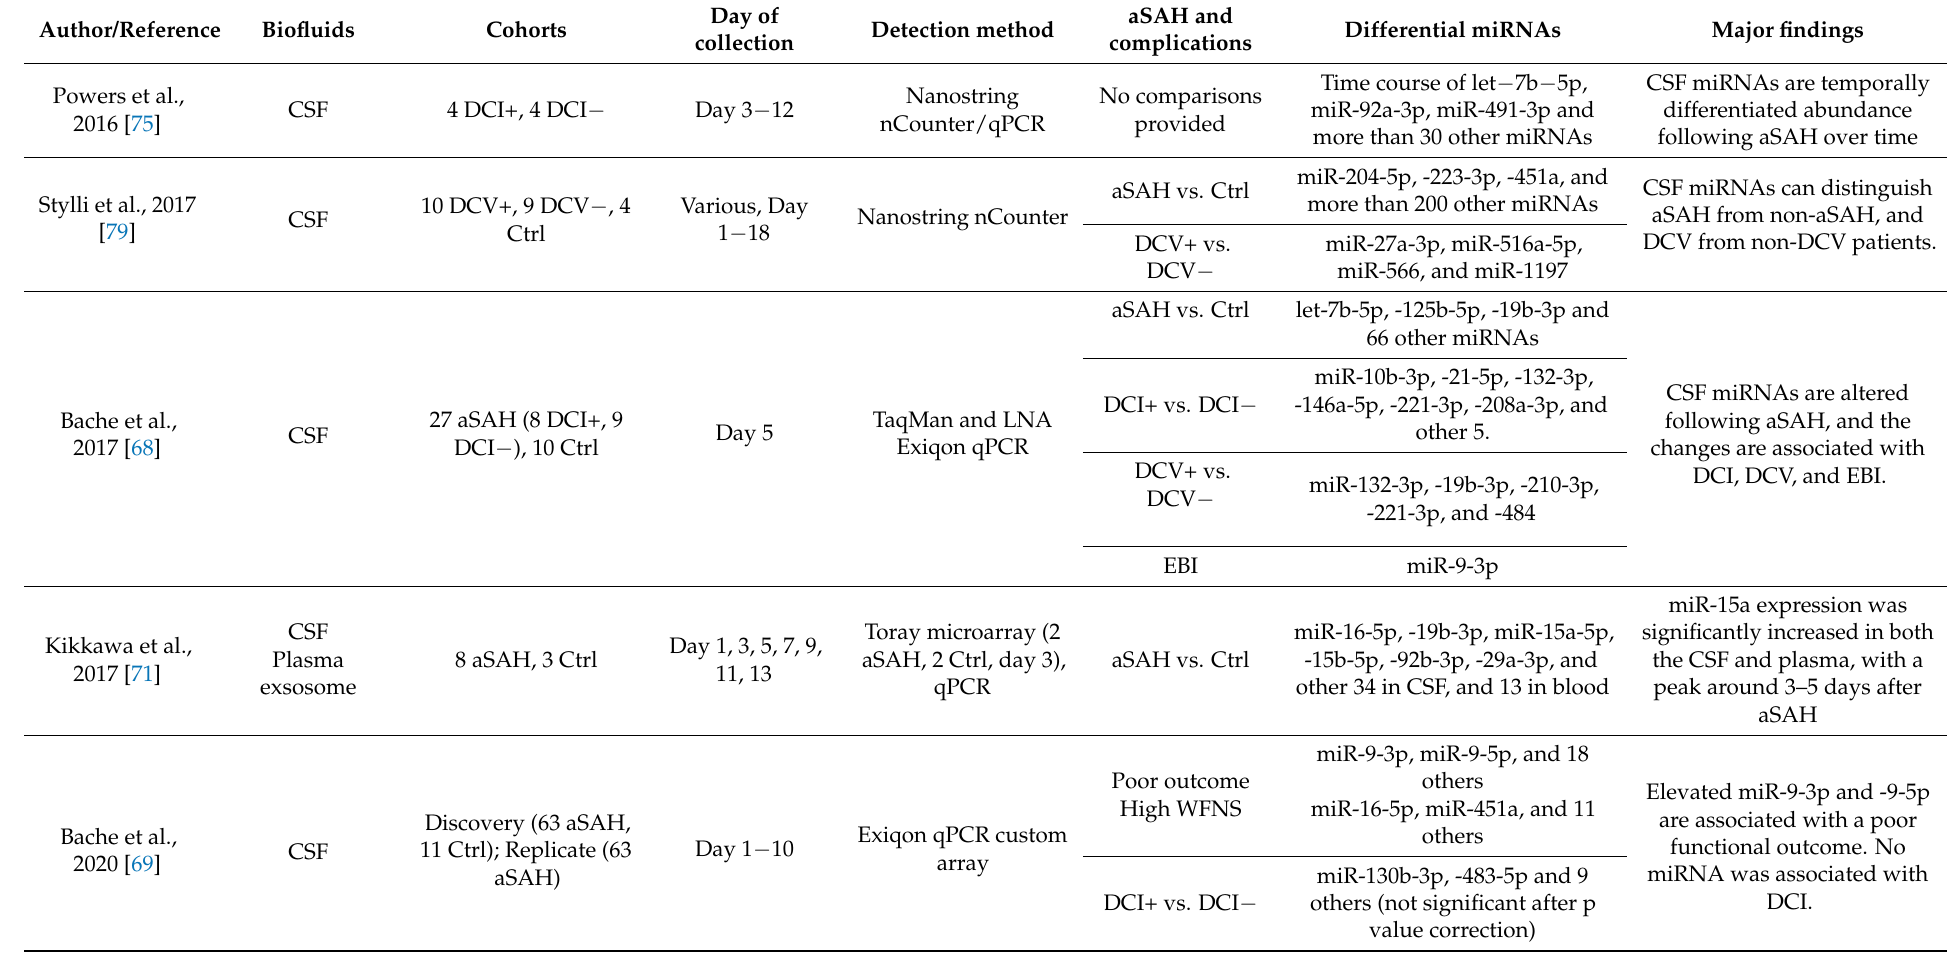
Table 2. Major studies investigating biofluid miRNAs as biomarkers in aSAH and